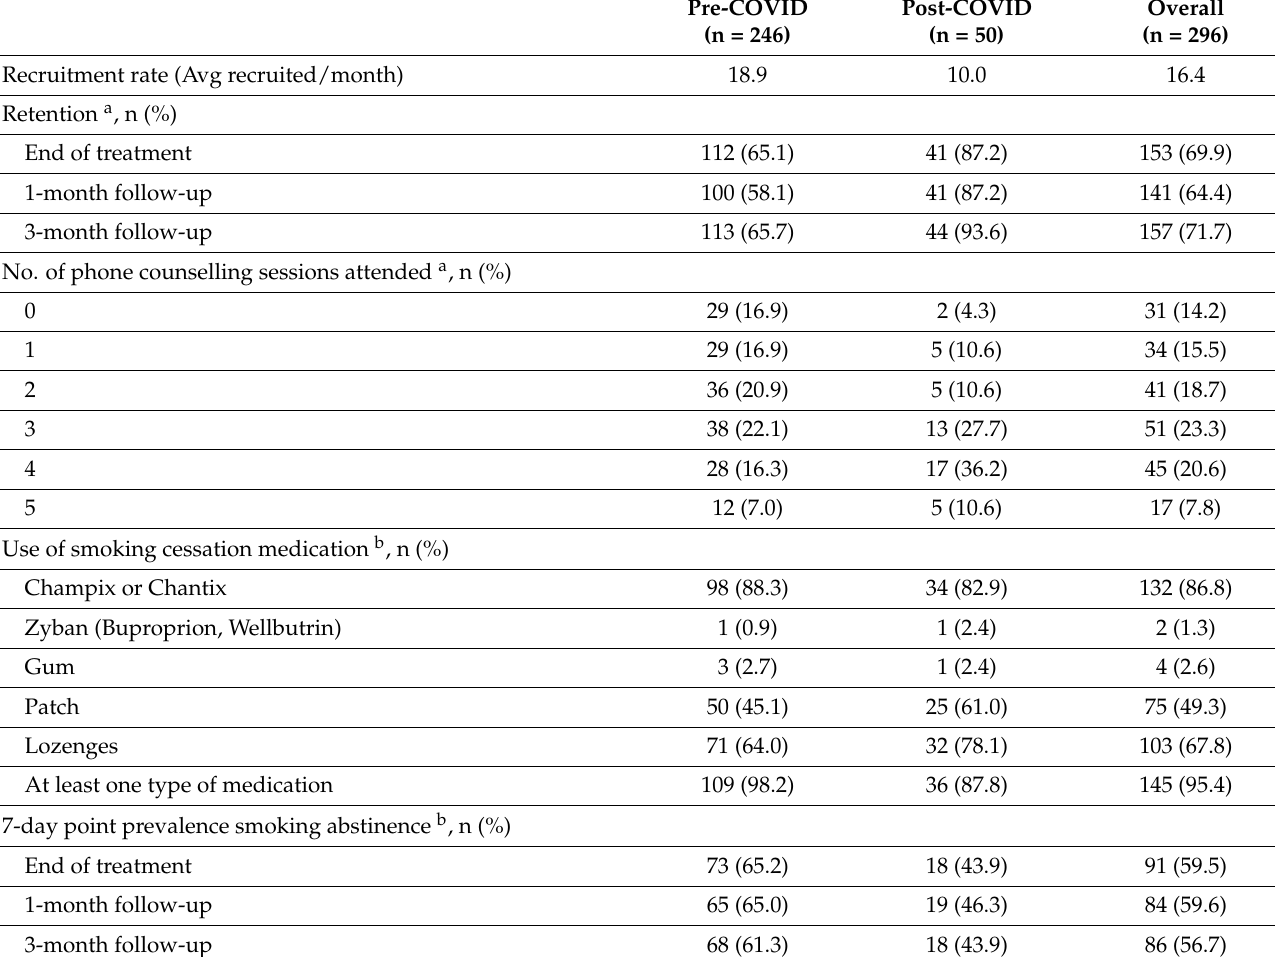
Table 2. Feasibility, acceptability, and quit outcomes (overall and stratified by pre-, post-COVID pandemic).